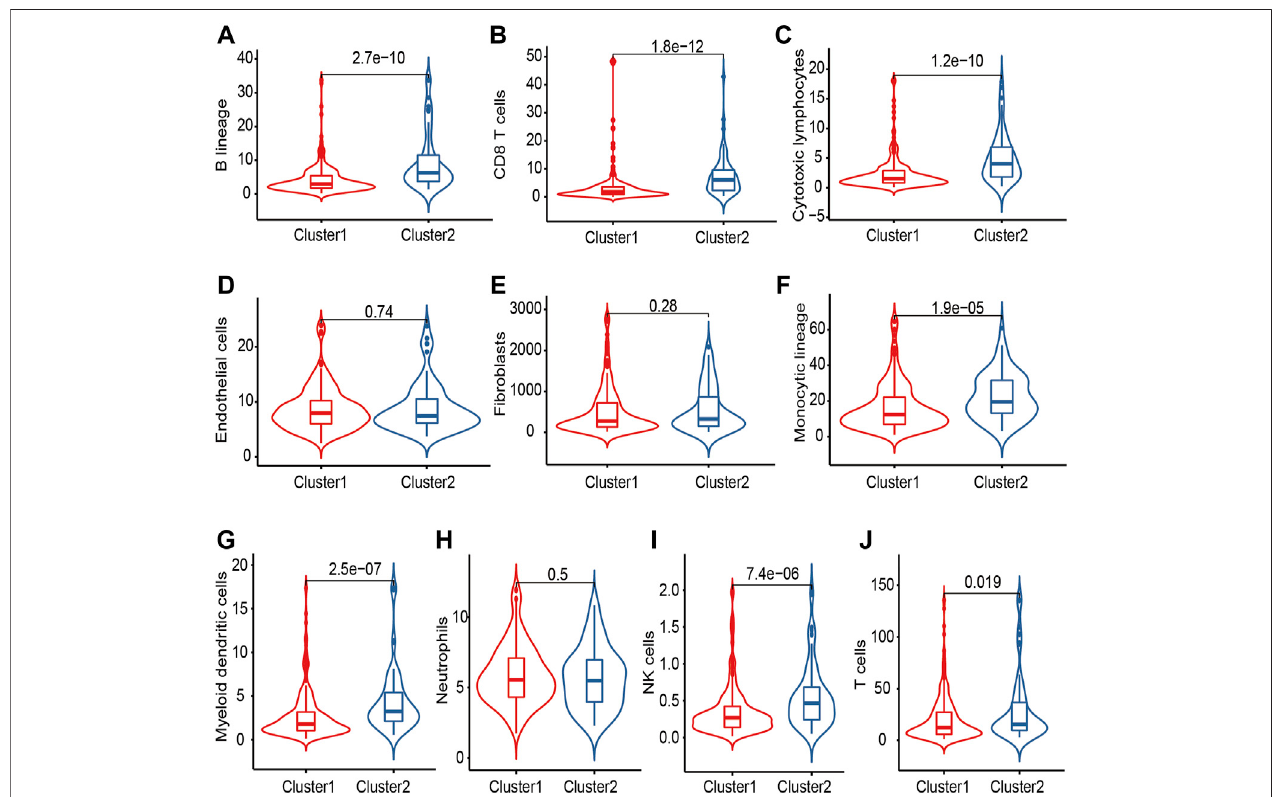
FIGURE3| TheimmunecelldistributioninOCpatientsoftwoclusters. (A) Bcells; (B) CD8 + Tcell; (C) Cytotoxiclymphocytes; (D) Endothelialcells; (E) Fibroblasts; (F) Monocytic cells; (G) Myeloid dendritic cells; (H) Neutrophils; (I) Natural killer cells; (J) T